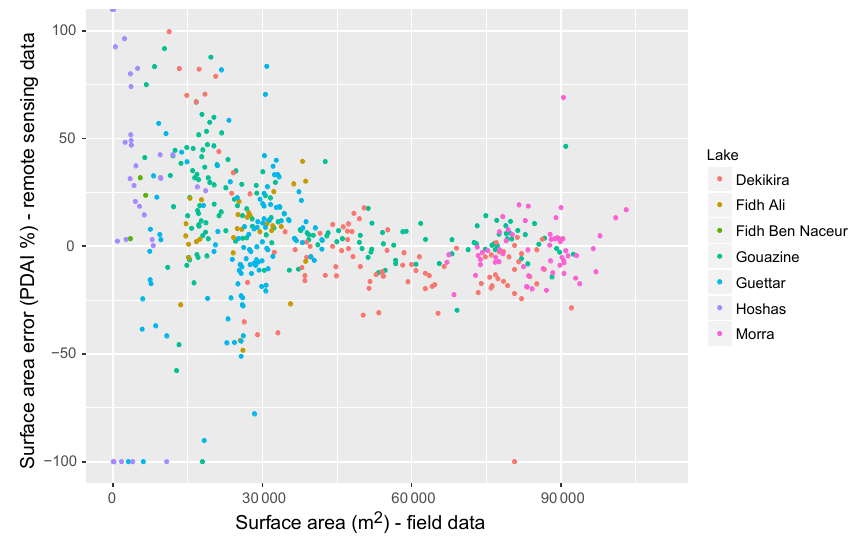
Figure 14. Surface area error (in PDAI%) from remote sensing data against field data for seven lakes.